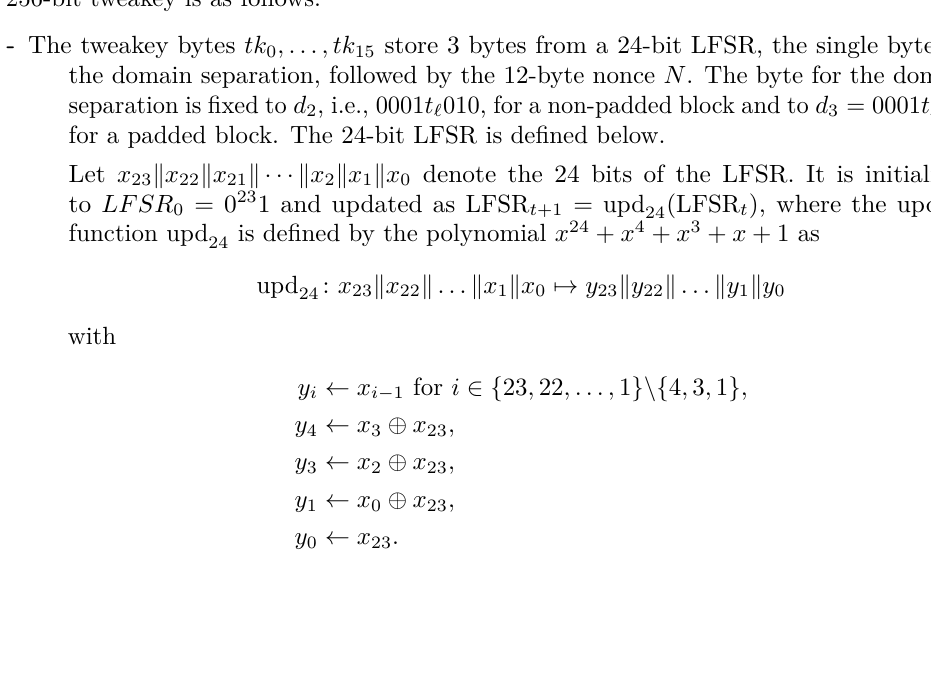
Figure 5: Encryption of SKINNY-AEAD with SKINNY-128-384 with padded message when t ‘ = 128. The last ciphertext block C l is further truncated to have the same size as M l m Again, we denote the block counter by 0 , . . . , ‘ m + 1 but actually refer to the state of the LFSRs serving as a block